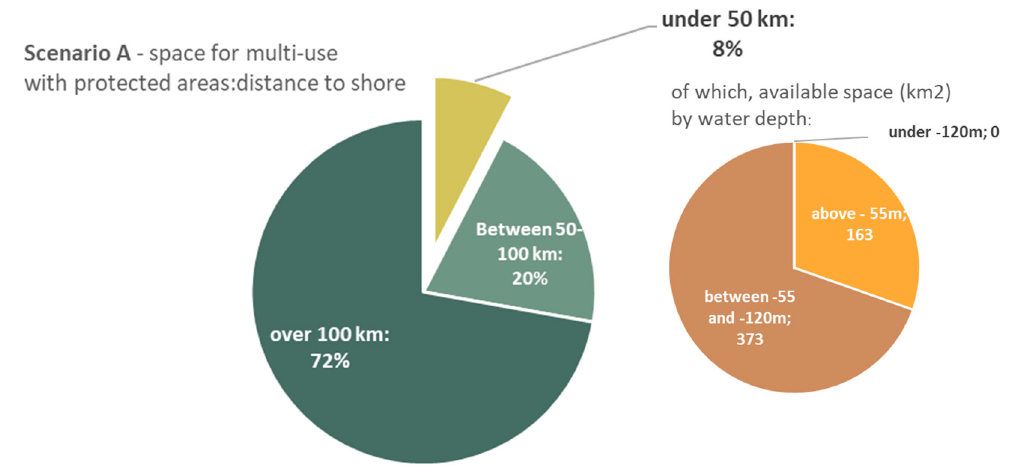
Figure 14. Percentage of areas for multi-use with protected areas proposed in Scenario A.